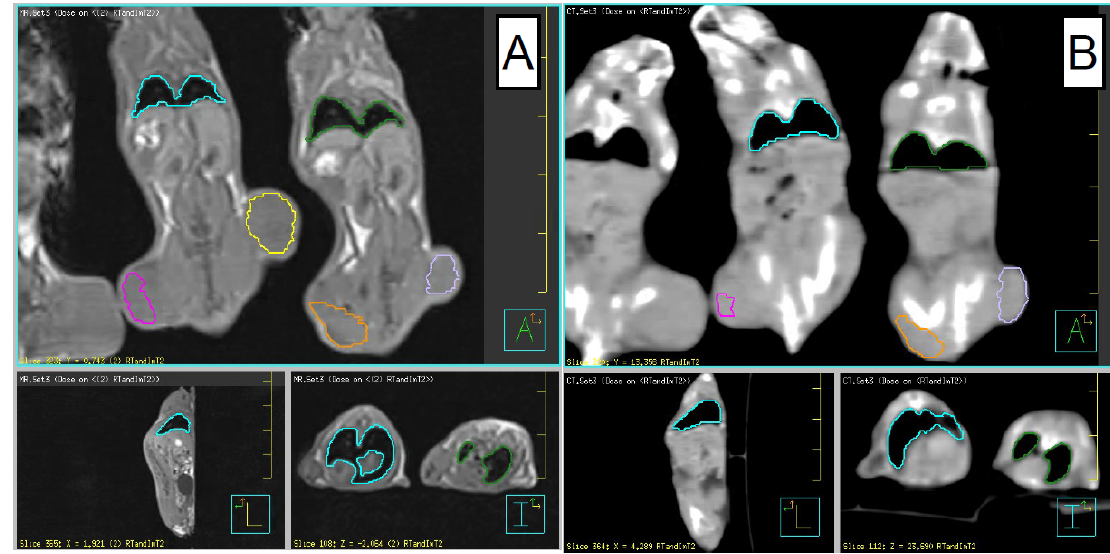
Figure 2. T1 3T MRI image (panel A ) and CT image (panel B ) of treated animals. The tumors on both flanks and the lungs are segmented for radiomics features extraction. The panels contain coronal ( top ), sagittal ( lower left ), and axial ( lower right ) views.